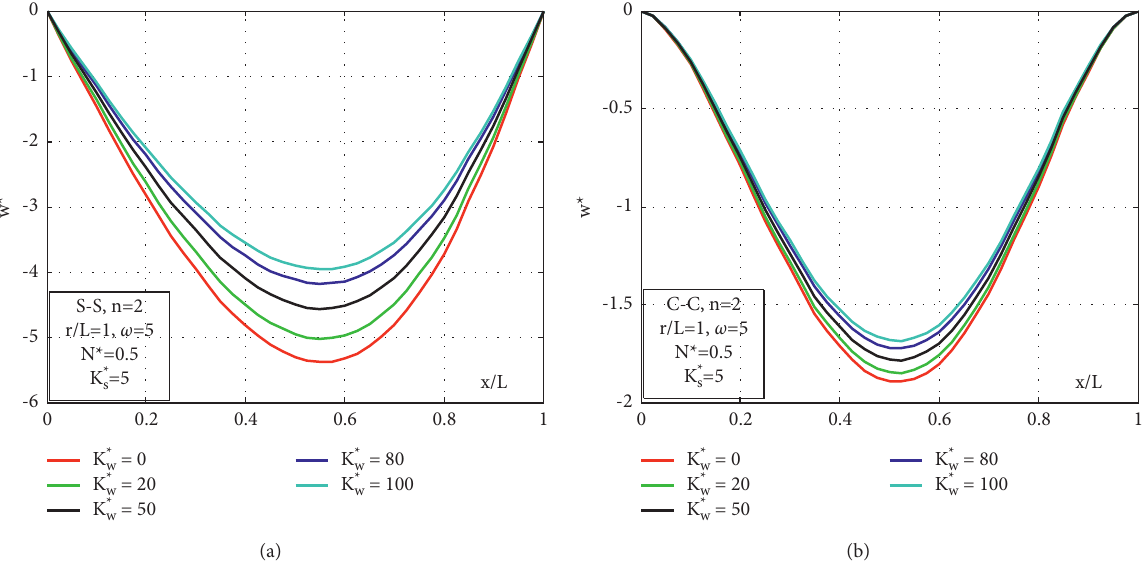
Figure 10: The dependence of the FG beam’s deflection curve on the elastic foundation parameter, K ∗